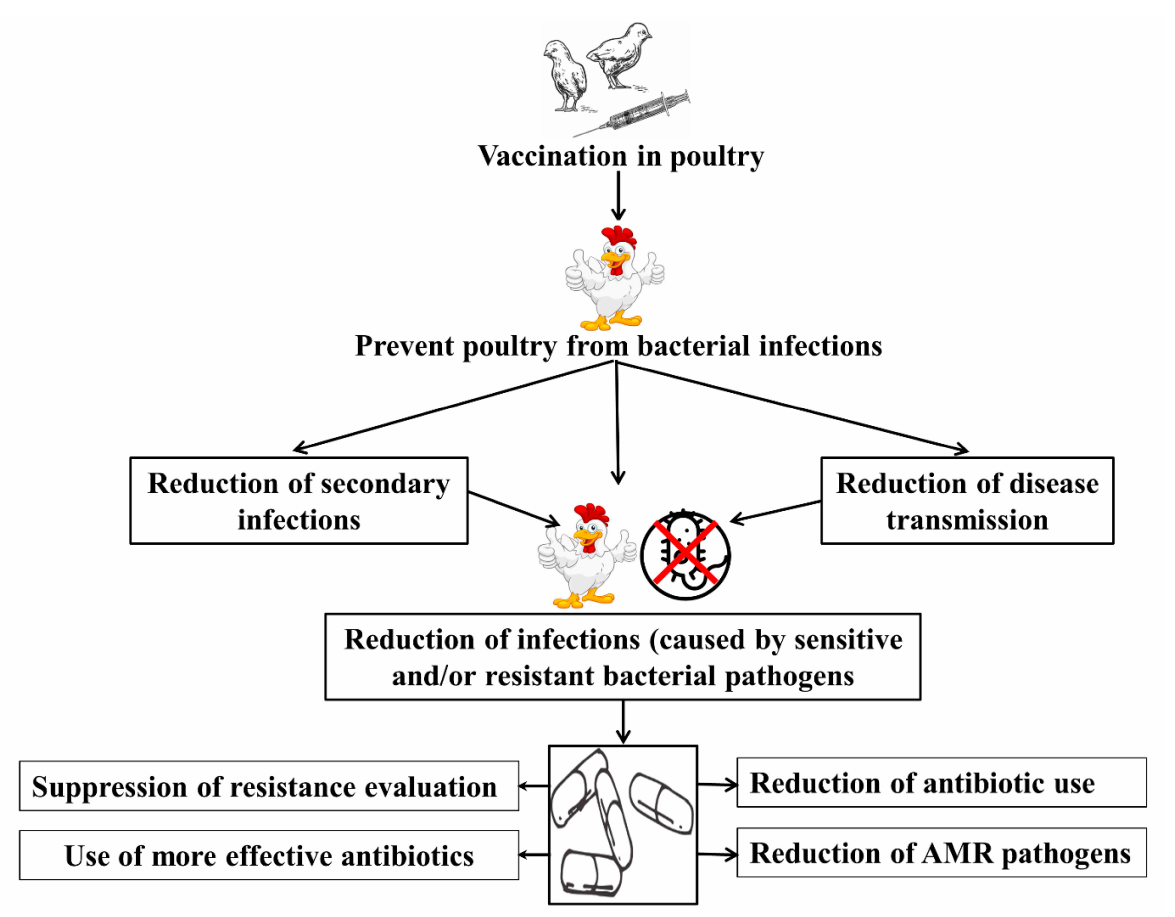
Figure 2. The role of bacterial vaccination in reducing the use of antibiotics and the occurrence of antimicrobial resistance in